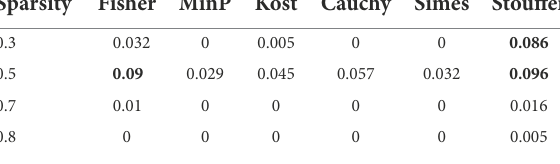
Bold value indicates to inflated type I errors.